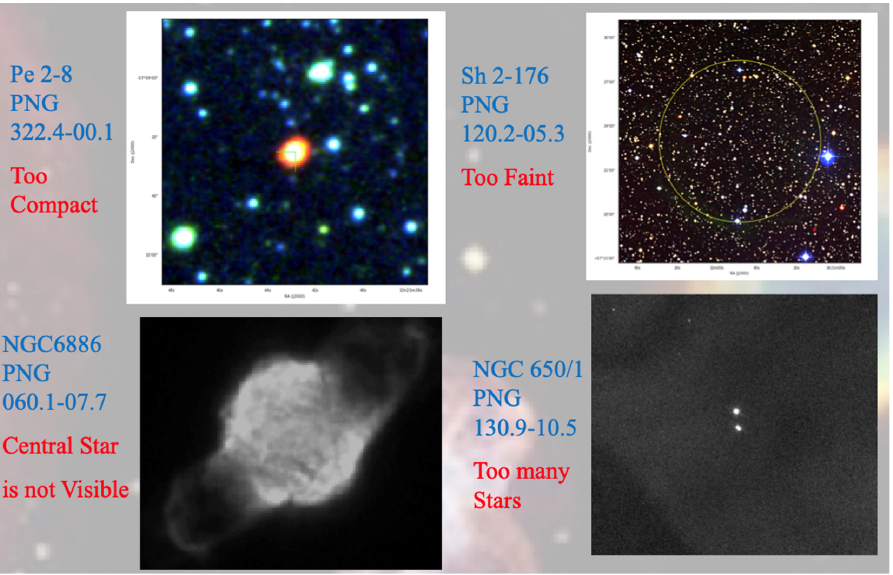
Figure 2. Four examples of different situations where we were unable to confirm the CSPN listed in [2]. The annotation for each panel is